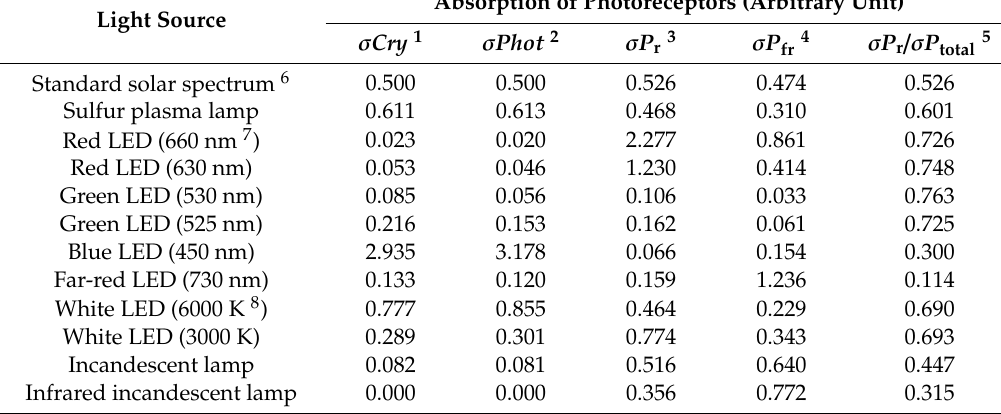
Table 2. Calculated absorptions of plant photoreceptors per 1 µ mol m − 2 s − 1 of photosynthetic photon flux density for di ff erent light sources.